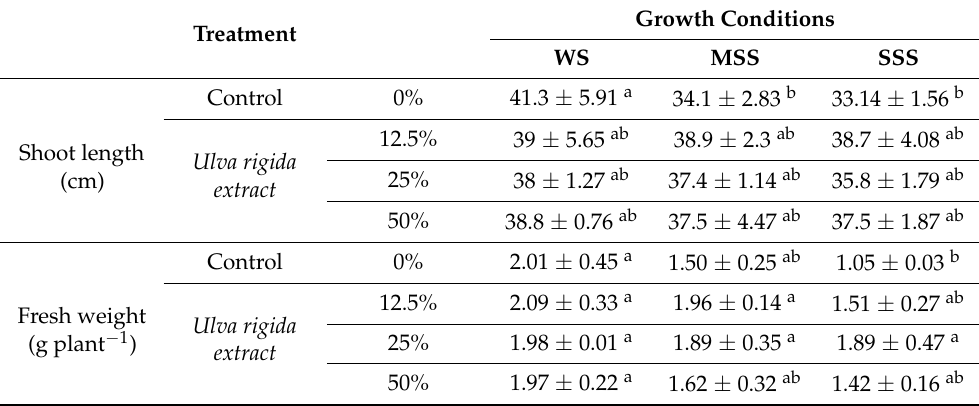
Table 3. The effect of Salt stress on shoot length (SL) and fresh weight (FW) of Triticum durum L. sprayed with SWE. Results are means ± SD ( n = 5). Different letters for each mean show statistically significant differences at p < 0.05. Abbreviations are as follows: WS: Without stress (0 mM of NaCl), MSS: Moderate salt stress (34.22 mM of NaCl), SSS: Severe salt stress (68.44 mM of NaCl), %: concentration of Ulva rigida extract in the solution of